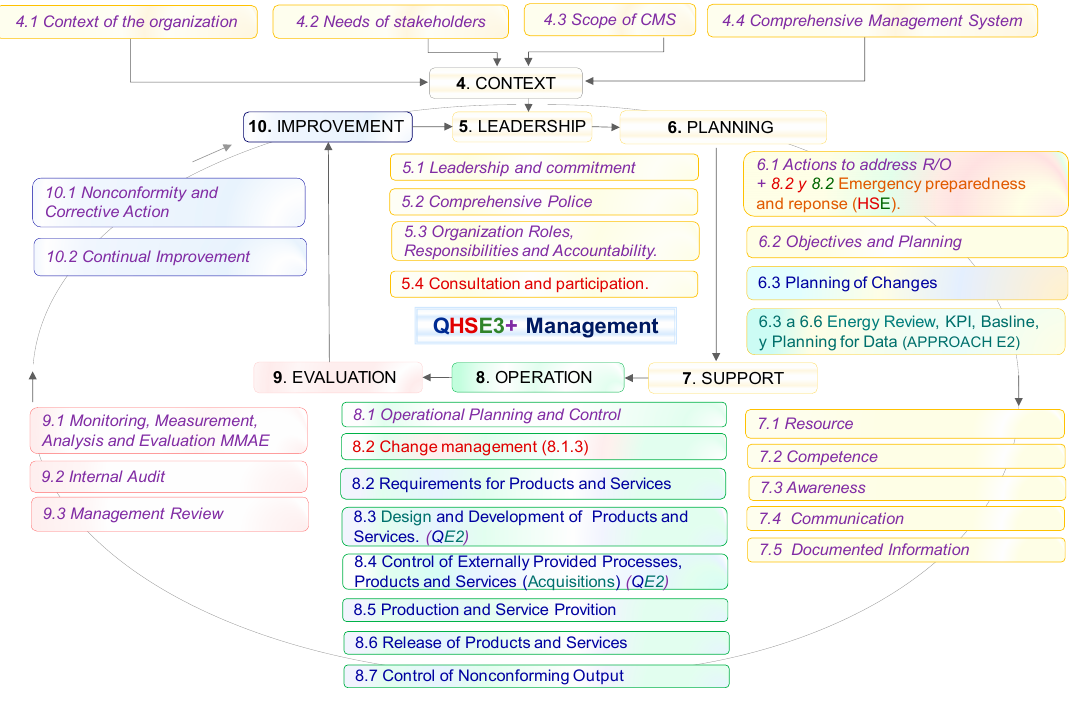
Figure 5. Integration of the logical structure of the requirements of CMS QHSE3 + . Perspective